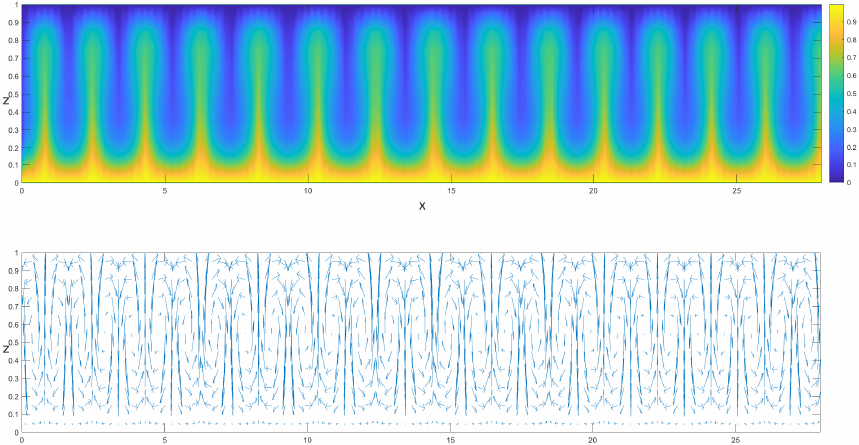
Figure 9. Isotherms and velocity field of the numerical solution obtained with finite elements; R = 5000 and Γ = 27.96.